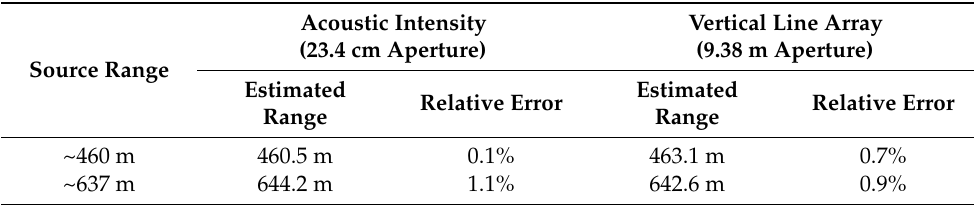
Table 1. Source–receiver ranges estimated based on beam-time migrations obtained using particle velocity and vertical line